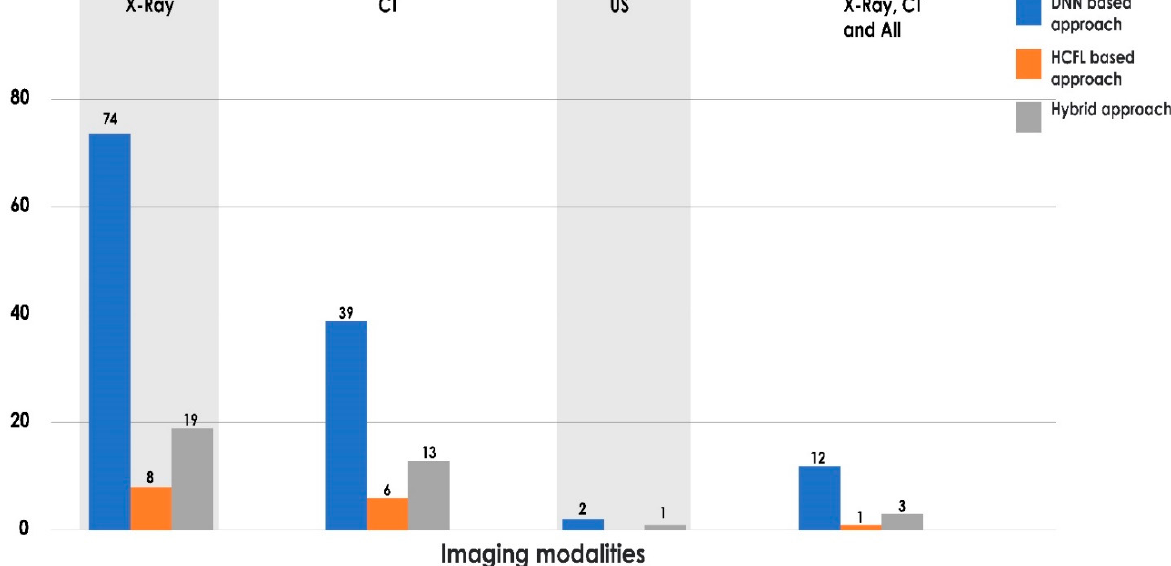
Figure 7. Various methodologies adopted by state-of-the-art techniques using different modalities.